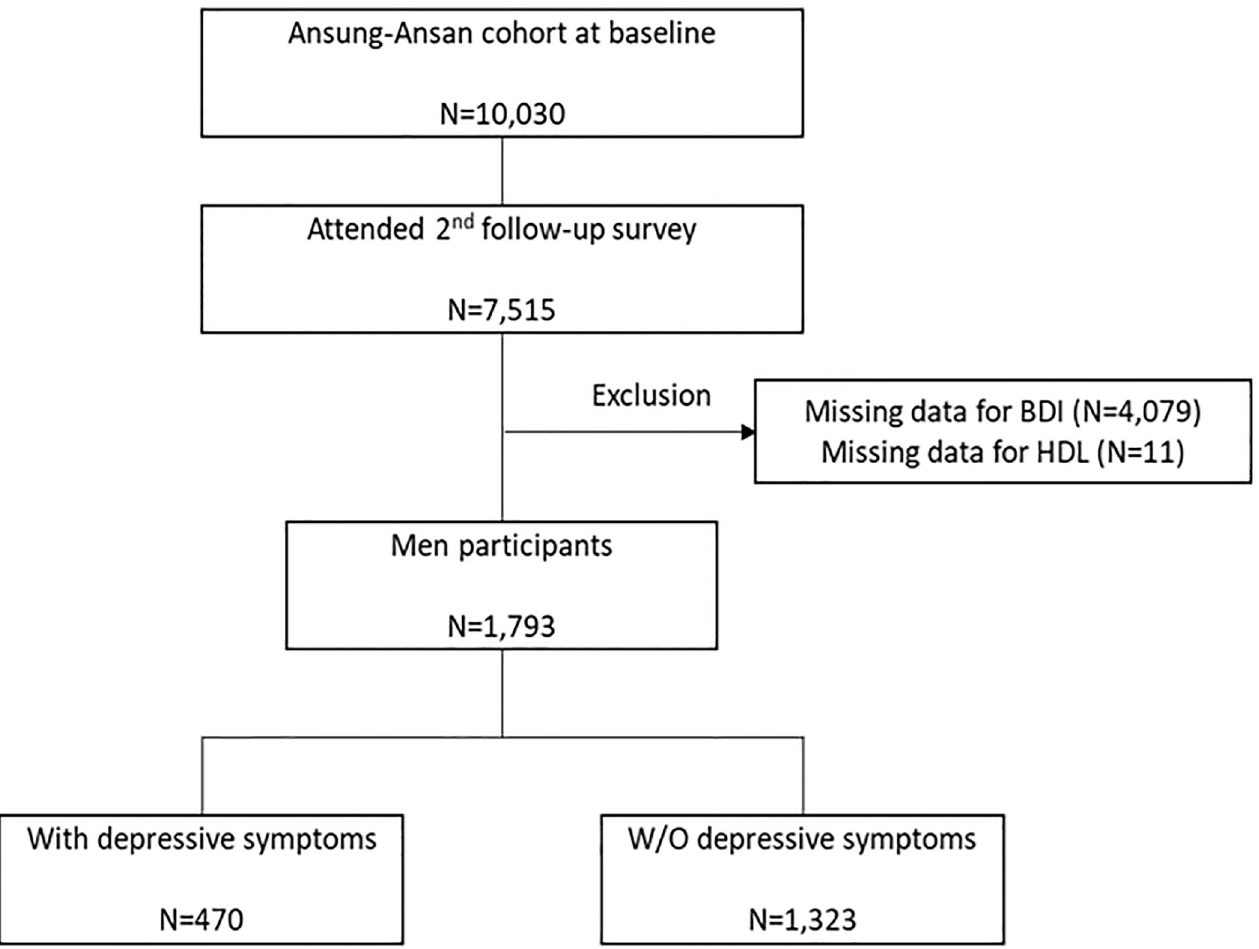
Fig 1. Flow chart showing the study population